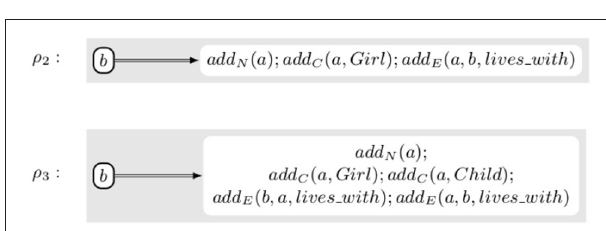
FIGURE 6 | Rules inserting the knowledge that Alice, who did not exist in the knowledge base, is a girl who lives with